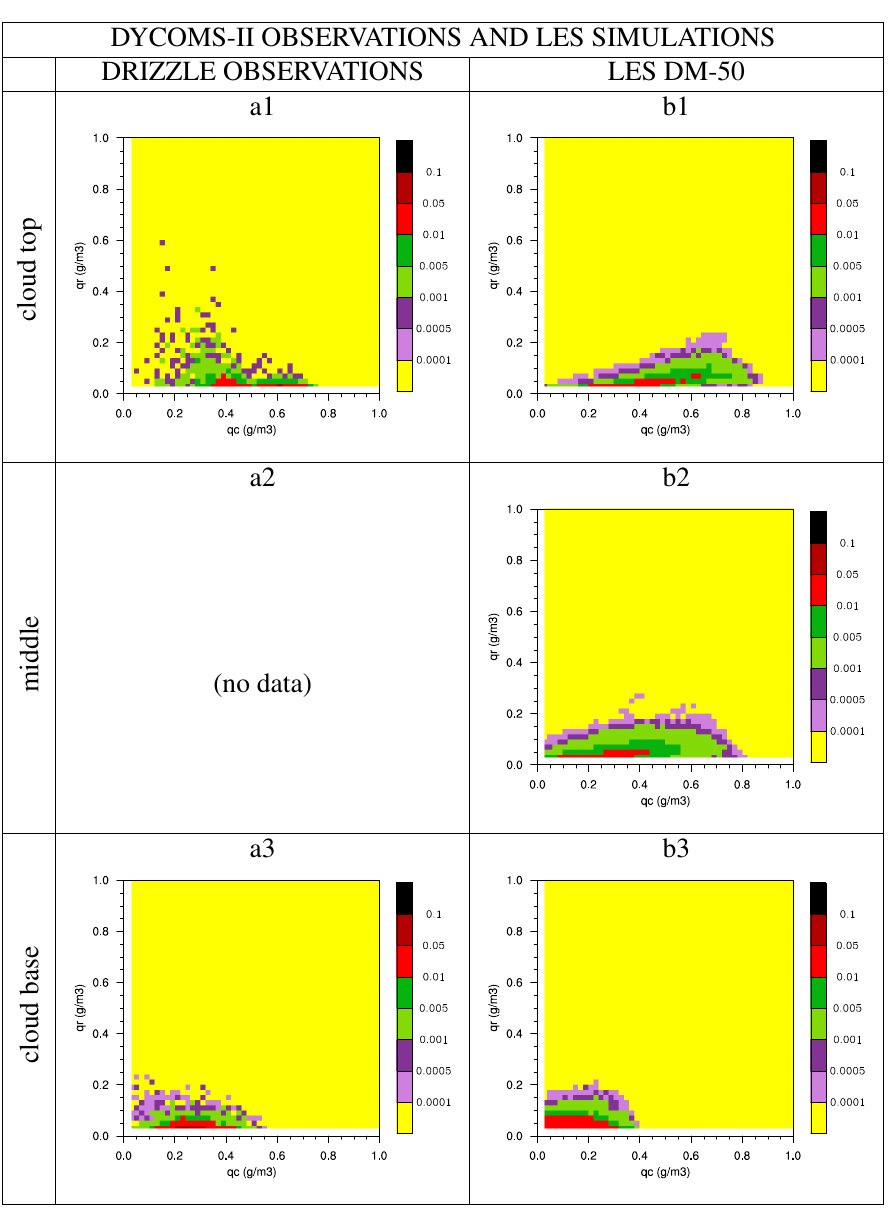
Figure 8: Joint probability distribution of q Fig. 8. Joint probability distribution of q c and q r for cloud top, middle part and cloud base using DYCOMS-II observations and LES simulation DYCOMS-II observations and LES simulation DM-50.